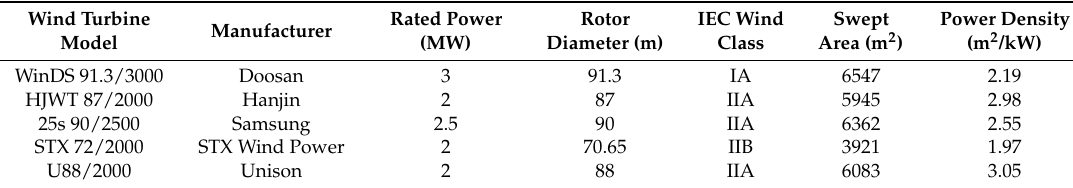
Table 7. Characteristics of selected wind turbines for